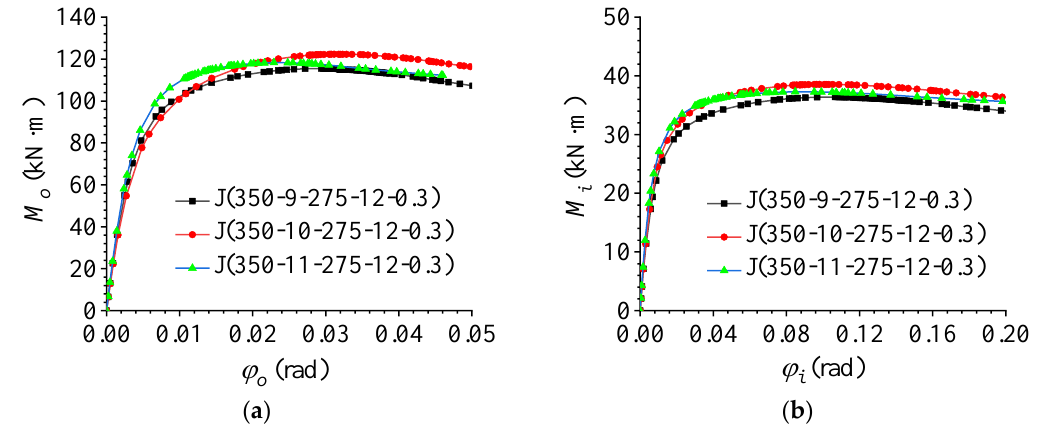
Figure 14. Effect of the number of bolts. ( a ) Out-of-plane M– ϕ curve; ( b ) in-plane M– ϕ